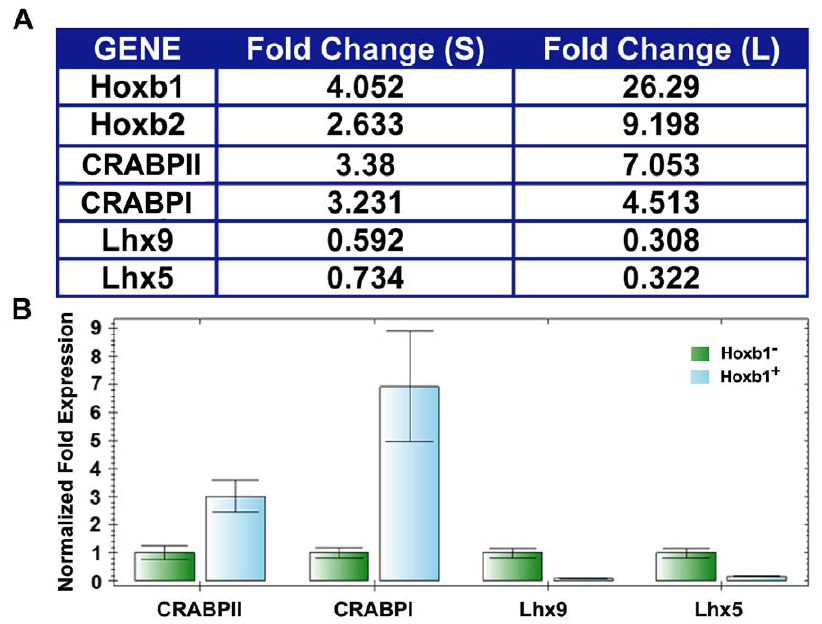
Figure 2. Hoxb1 regulation of selected genes validated by RT-PCR. (A) Hoxb1 mediated fold regulation of CRABPI , CRABPII and Lhx5 and Lhx9 expression in the short (s) and long (l) induction schemes. As a comparison, the regulation of two know Hoxb1 targets, Hoxb1 itself and Hoxb2 is shown. (B) Real – time PCR confirmation of differences in the expression of CRABPI and II and Lhx9 and 5 in Hoxb1 2 and Hoxb1 + cells.